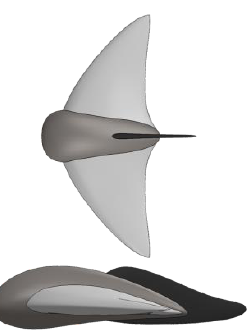
Figure 1. ATAA large wing glider shape.